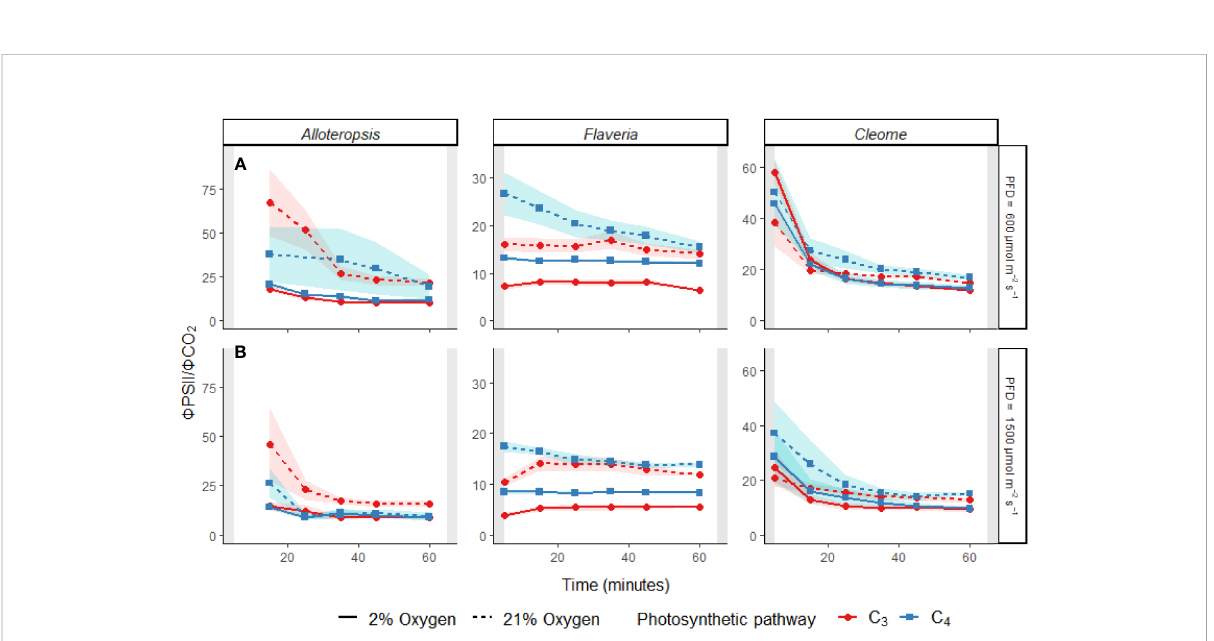
FIGURE 6 Line plots of the F PSII/ F CO 2 ratio during light induction at PFD = 600 µmol m -2 s -1 (A) and PFD = 1500 µmol m -2 s -1 (B) in phylogenetically linked C 3 and C 4 Alloteropsis , Flaveria and Cleome species. Plots show F PSII/ F CO 2 under 21% (dashed line) and 2% O 2 (solid line). Values of F CO Alloteropsis values being excluded. Ribbons show standard F PSII/ F CO 2 were excluded if 2 values were negative, resulting in the 5 minute error of the mean (n =